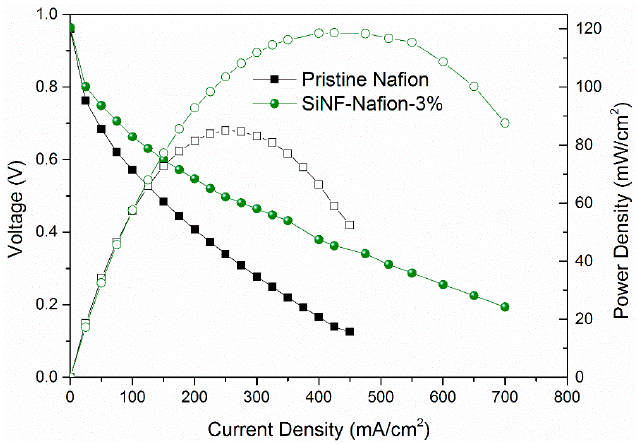
Figure 5. Polarization and power density curves of the pristine Nafion and SiNF-Nafion-3% membranes under 20% RH and humidified under H 2 and O 2 atmospheres at 110 ° C.